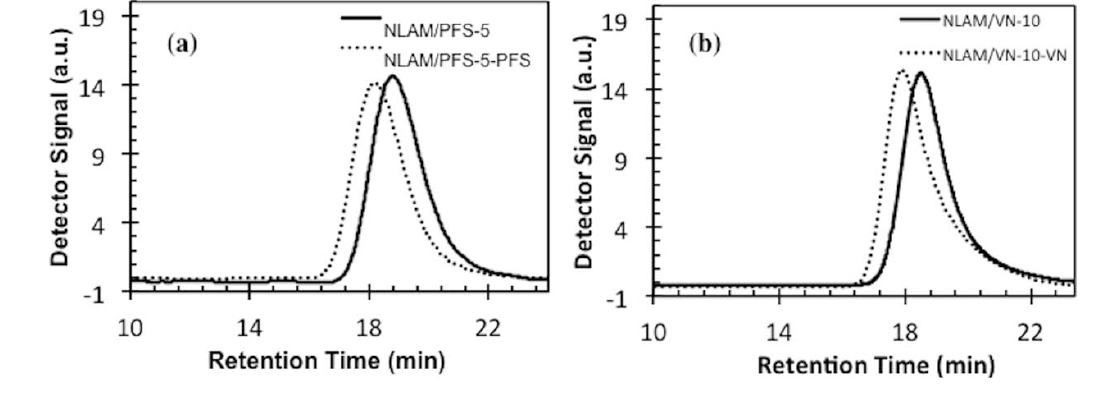
Figure 4. GPC chromatograms of macroinitiators (solid line) and chain extended polymers (dotted line) in the chain extension experiments: and ( b )